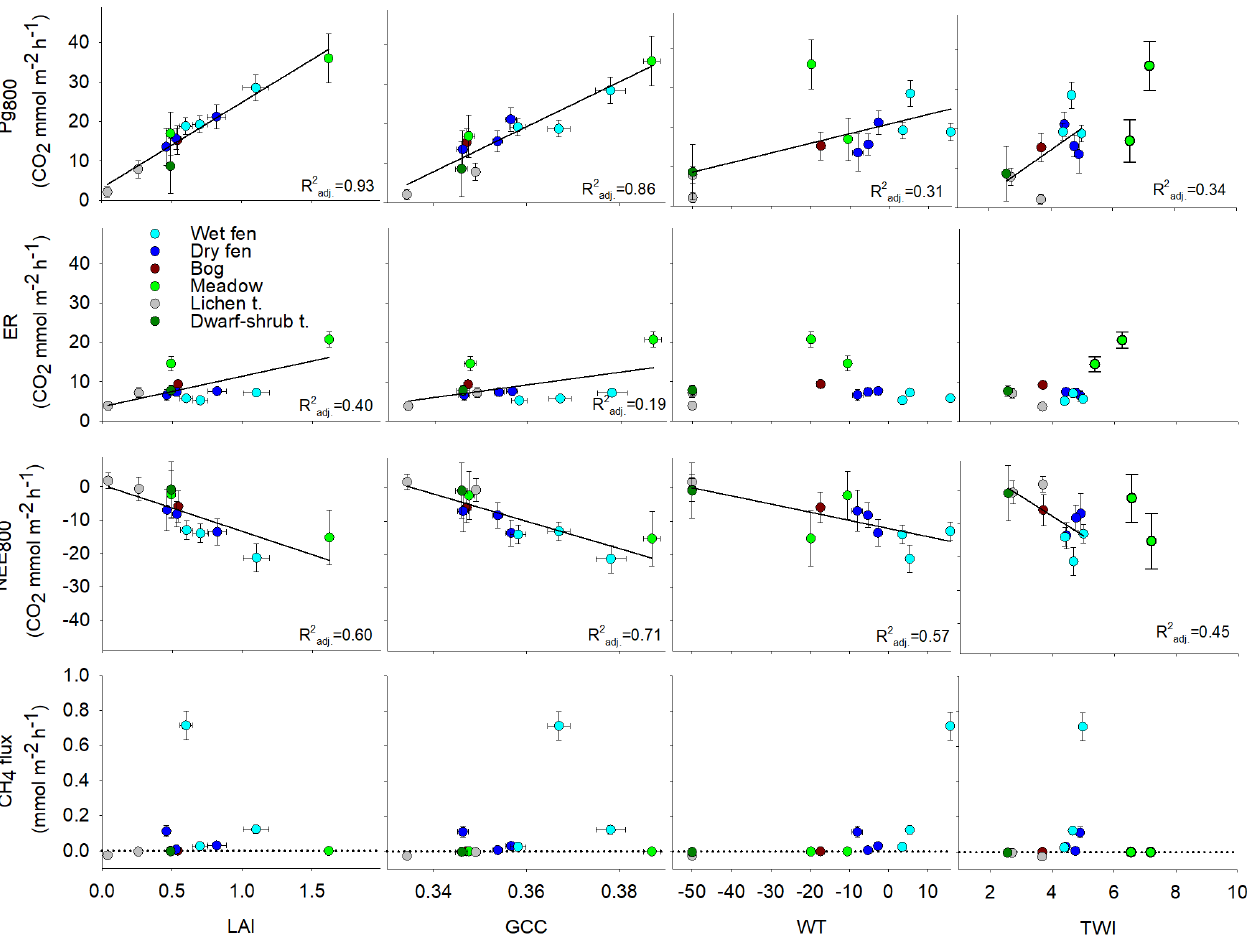
Figure 3. Variation in the estimates of Pg 800 , ER, and NEE 800 (Eq. 1) and collar means of CH 4 fluxes in relation to variation in the collar means of LAI, GCC, WT, and TWI during 6 July–16 August 2014. Error bars denote the standard error of estimate ( n = 15 or 16). Fitted regression lines and adjusted coefficients of determination ( R 2 ) are included for the significant linear relationships. The two meadow plots adj . were not included in the TWI